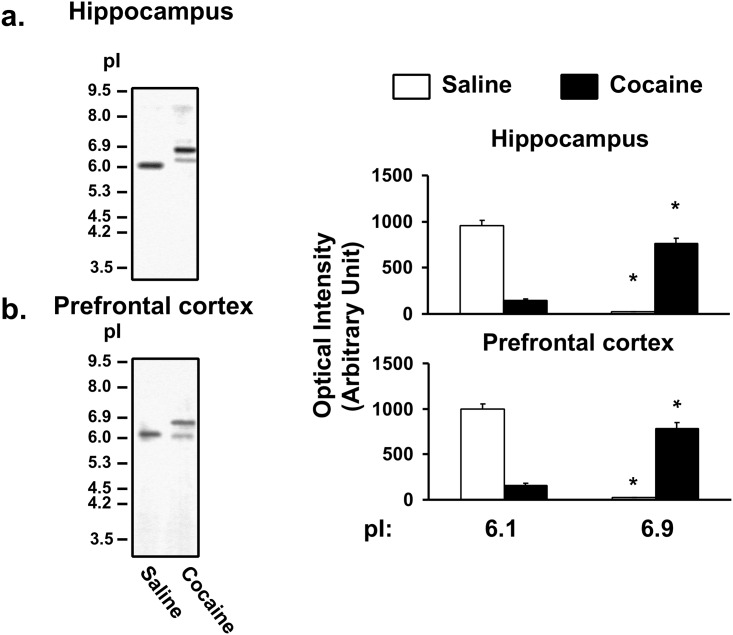
Prenatal cocaine exposure altered 145-KDa TrkB conformation in hippocampi (top) and PFCX (bottom).The conformational states of the immunopurified 145-KDa TrkB was analyzed by separating on pH3-10 isoelectric focusing gels and then Western blotted with anti-TrkB. Blots were quantified by densitometric scanning. Data are means ± s.e.m. of the pI 6.1 and pI 6.9. n = 5 (3 males and 2 females). p < 0.01 compared to respective protein in the saline-treated group.